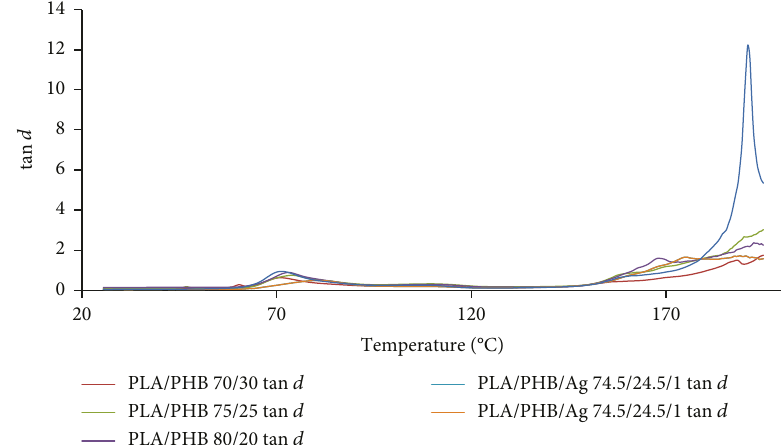
Figure 4: Tangent delta vs. temperature.